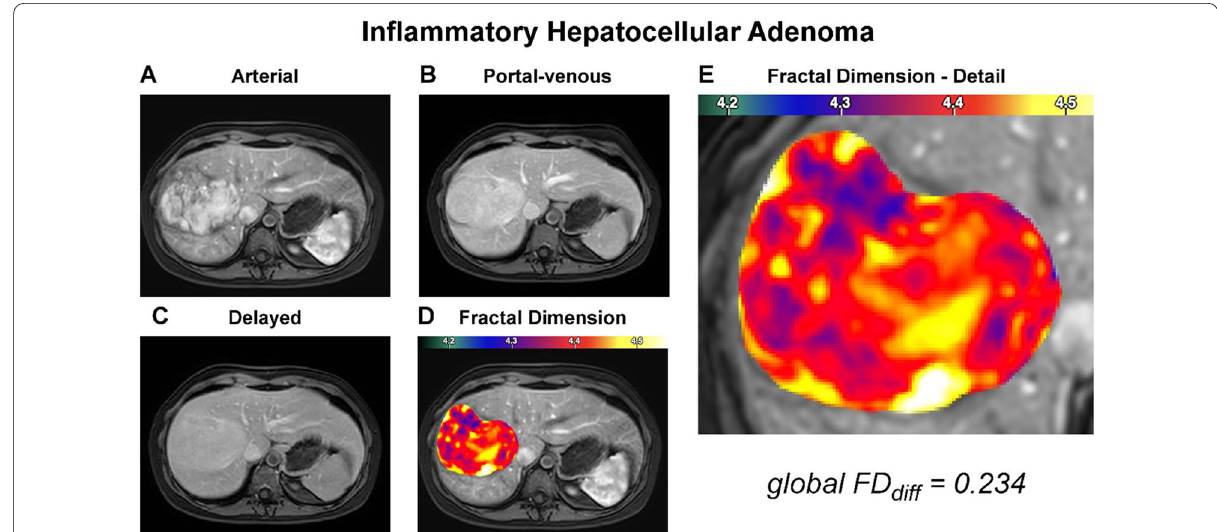
Fig. 4 Representative case of inflammatory hepatocellular adenoma. The panel organization is the same throughout Figs. 2, 3, 4, and 5. The depicted patient was a 25-year-old female with a liver mass incidentally discovered during exploration for a chronic inflammatory state. Arterial phase hyperenhancement, persistent hyperintensity during the portal and delayed phases, and marked T2 hyperintensity (not shown) suggested inflammatory adenoma, which was confirmed by biopsy